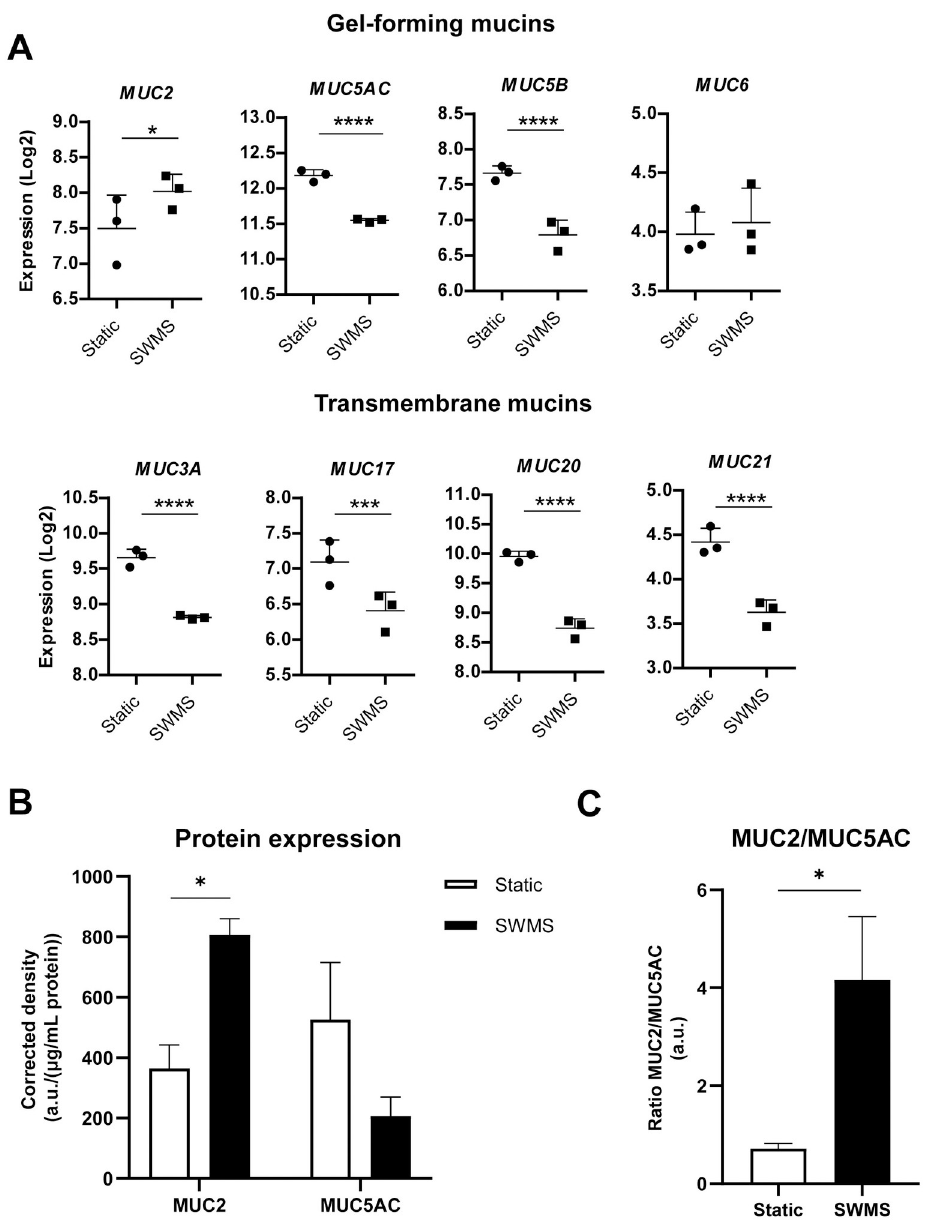
Fig 2. Mucin gene and protein expression in HT29-MTX-E12 cells grown under static and SWMS conditions. A) Microarray gene expression values (Log2) of a panel of secretory and transmembrane mucins B) Protein expression of MUC2 and MUC5AC, expressed as density (a.u.) per μ g/mL protein blotted, after correction of Ponceau Red density. Blot data in S2 Fig) C) Ratio of MUC2 and MUC5AC protein expression. � p < 0.05; ��� p < 0.001; ���� p < 0.0001; n = 3 biological